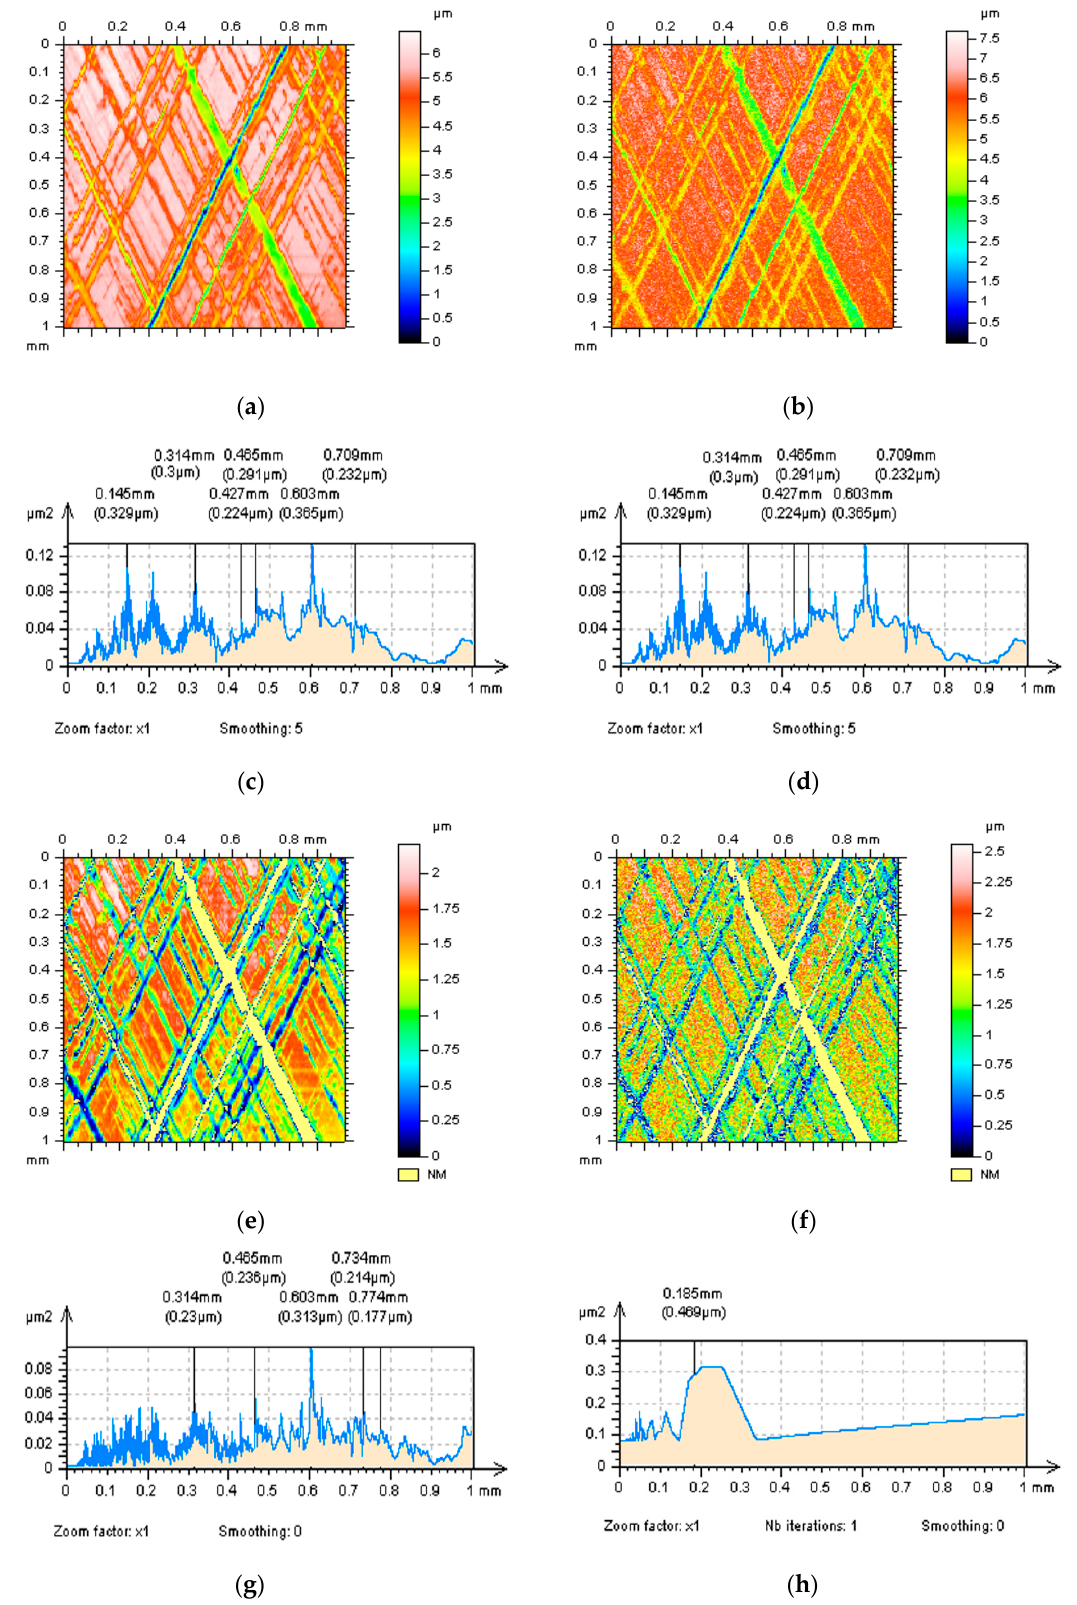
Figure 6. Cylinder liner surface measured with 0.3 mm/s ( a , e ) and 0.7 mm/s ( b , f ) speed, with the PSDs ( c , d , g , h ) respectively, received for the regular ( a – d ) and PVTM ( e – h ) methods.